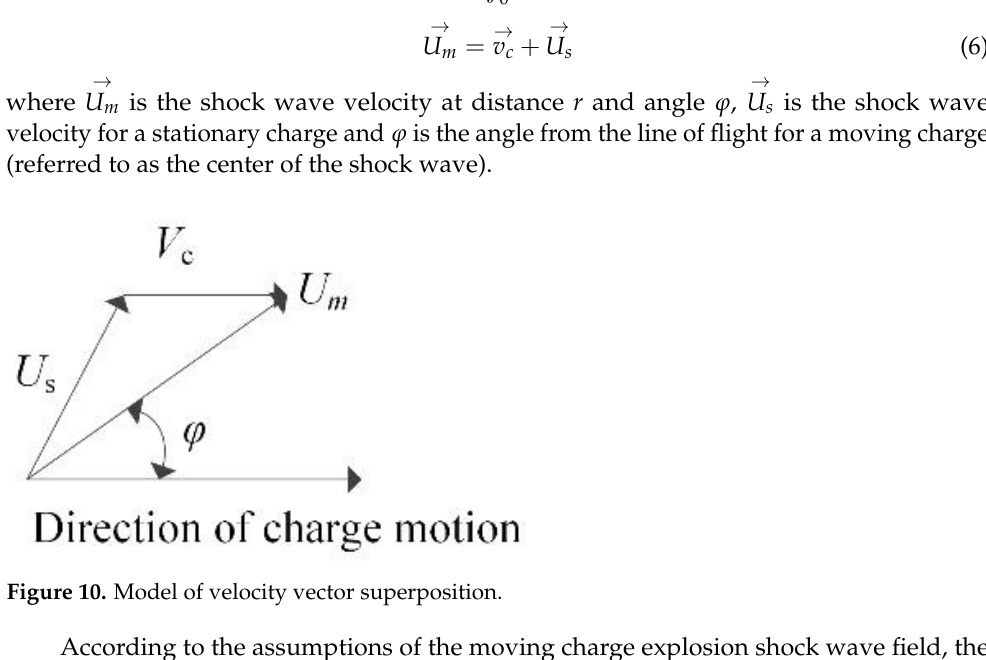
Figure 10. Model of velocity vector superposition. According to the assumptions of the moving charge explosion shock wave field, the shock wave model was established in Figure 11. The distance and angle from the center were as follows: